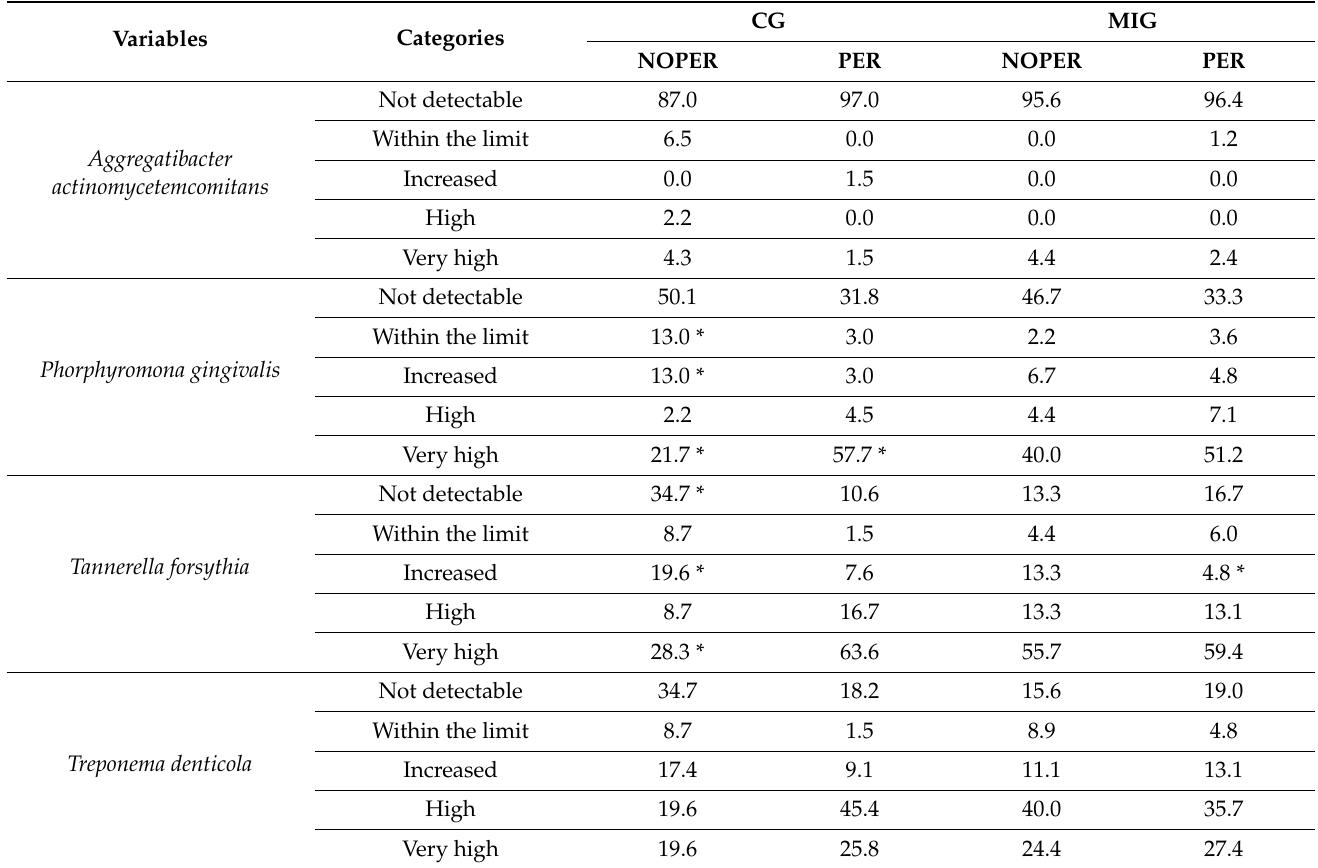
Table 4. Microbiological parameters of the four groups expressed as bioburden categories and percentages; Chi-square